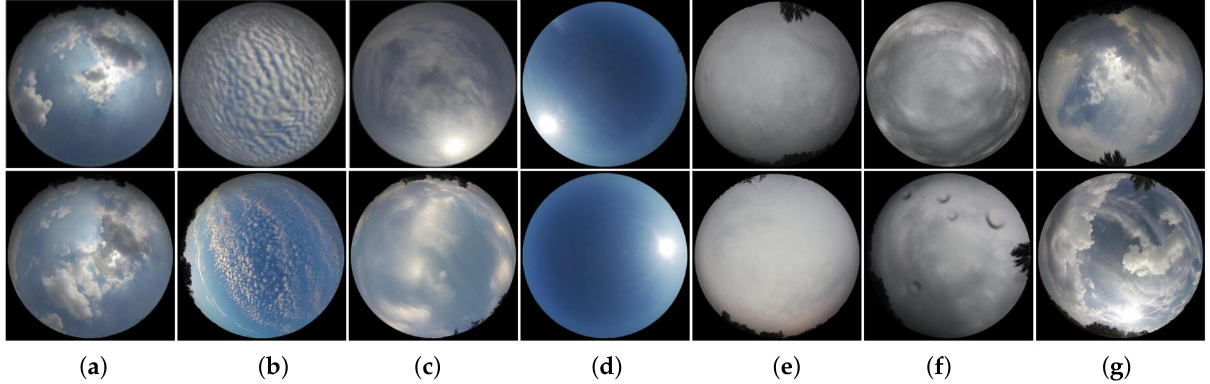
Figure 9. MGCD dataset. ( a ) Cu; ( b ) Ac and Cc; ( c ) Ci and Cs; ( d ) clear sky; ( e ) Sc, St and As; ( f ) Cb and Ns; ( g ) mixed. This dataset combines altocumulus and cirrocumulus, cirrocumulus and cirrostratus, stratocumulus and stratus and altostratus, and cumulonimbus and nimbostratus,